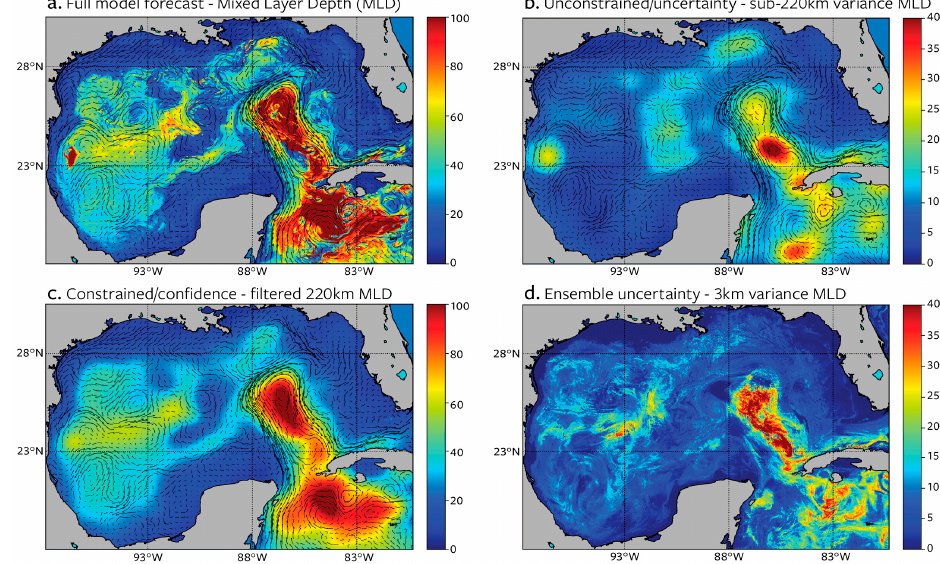
Figure 9. Model forecasts for 20 March 2016 are shown for the Mixed Layer Depth (MLD) for ( a ) the full model (Navy Coastal Ocean Model (NCOM)), ( b ) the unconstrained or uncertainty portion, and ( c ) the constrained or confident portion of the forecast. ( d ) A comparison with 32-member ensemble at only 3 km resolution uses the MLD from each ensemble member to compute the standard deviation across the ensemble. The uncertainty features in the two right panels are a result of the larger-scale features modulating the placement and development of the smaller scales.